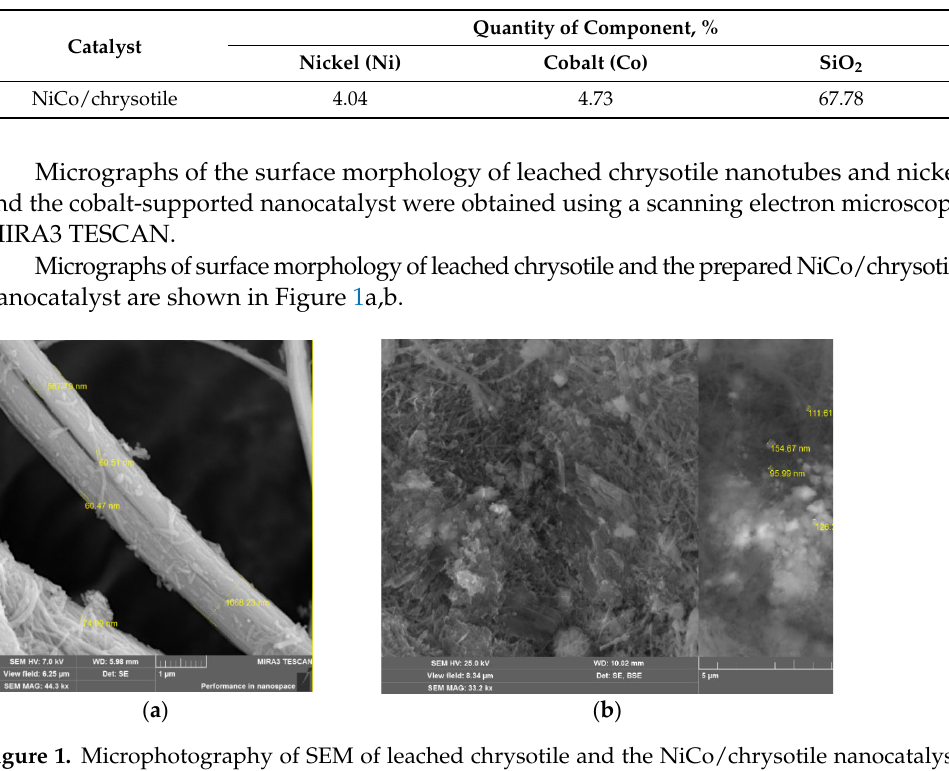
( b ) Figure 2. Isotherms of leached chrysotile adsorption and NiCo/chrysotile nanocatalyst: ( a ) leached chrysotile; ( b ) NiCo nanocatalyst/chrysotile. From the nitrogen adsorption isotherm of leached chrysotile and NiCo/chrysotile nanocatalyst obtained in the range of relative partial pressures P/P 0 = 0.05 − 1 , it is difficult to determine the nature of the pores. However, according to de Boer’s classification, it resembles a hysteresis loop of type H3 [18], which means that the pores are considered mainly hole ‐ like. The catalyst support (chrysotile) is an adsorbent structured material since the pores are nanotubes, channels, and cavities in the solid matrix. Table 3 shows the specific surface area and the specific pore volume of the leached chrysotile and the NiCo/chrysotile nanocatalyst.